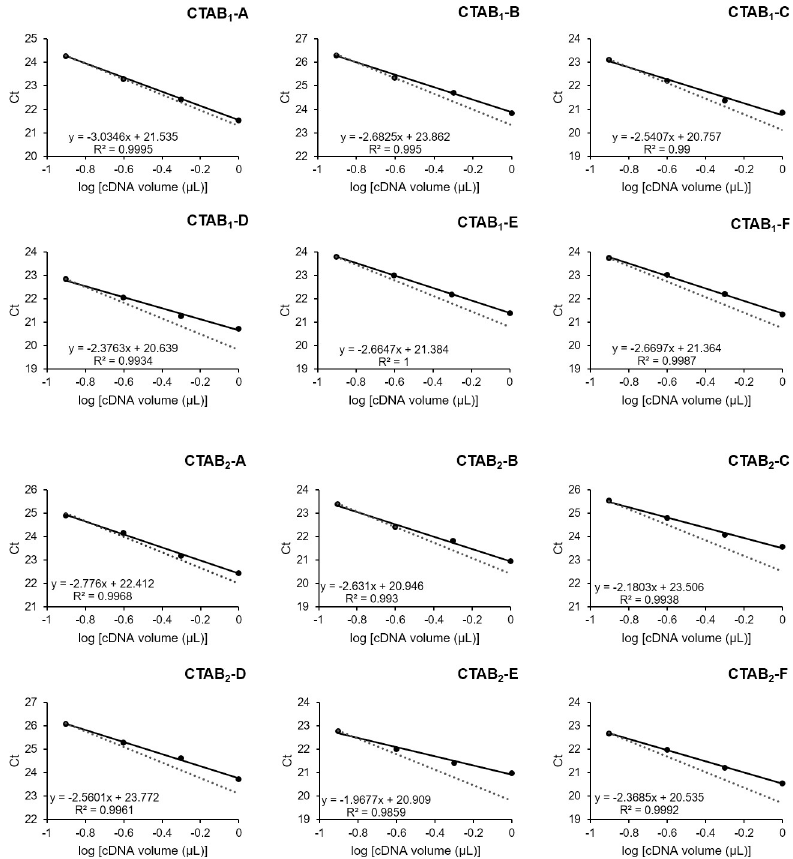
Fig 3. Quantitative analysis by RT-qPCR to compare CTAB methods. Linear regression curves of the real-time reverse transcription polymerase chain reaction assay based on serial dilutions of cDNA (1.0, 0.5, 0.25, and 0.125 μ L) synthesized from the same volume of RNA (5 μ L) were used for all samples. The log of cDNA volume ( μ L) is indicated on the x-axis, whereas the corresponding Ct values are shown on the y-axis. Each dot represents the mean result of three replicates. The correlation coefficient (R 2 ) and linear equation of the regression analysis are shown. Values obtained in this assay for each sample are represented in solid lines and ideal values in dotted lines, estimated based on the Ct values of the highest dilution, considering an efficiency of one hundred percent in each